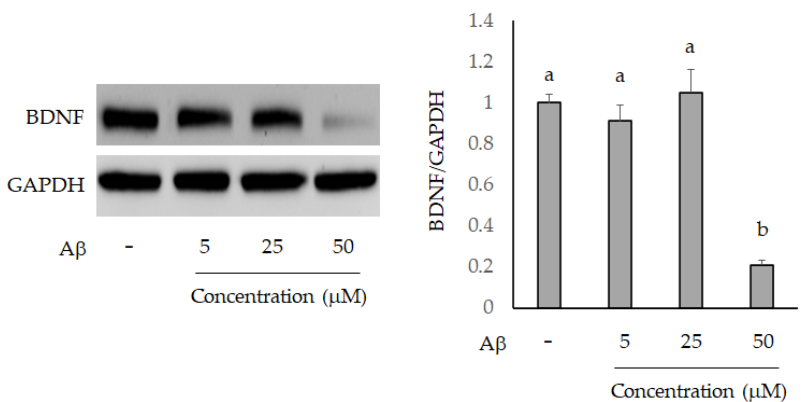
Figure 5. The impairment of BDNF in Neuron-2A cells treated by A β for various concentrations for 36 h. Data are shown as means ± SD ( n = 3). Significant differences are shown by various letters ( p < 0.05).